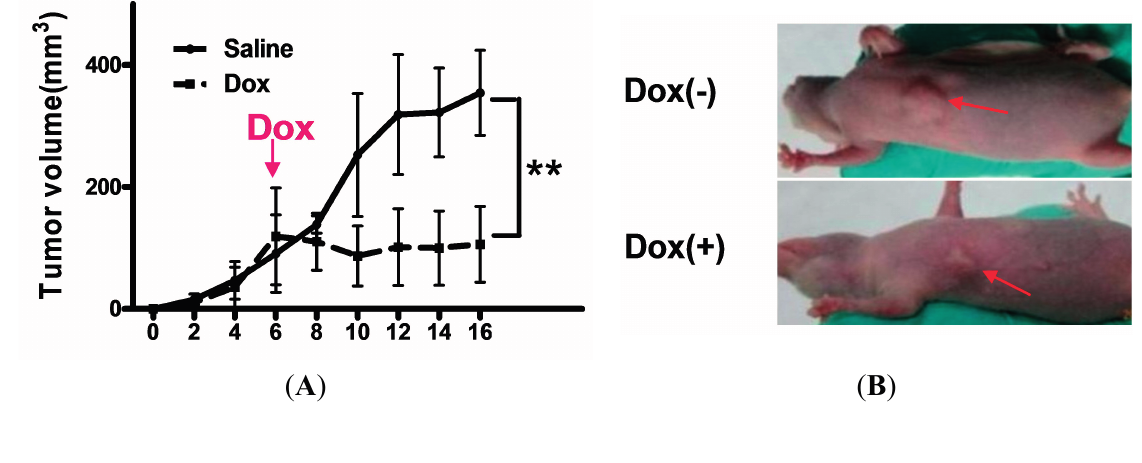
Figure 5. Shutdown of Bmi1 represses the growth of the fast growing tumor in nude mice. ( A ) The growth of tumors in mice with or without doxycycline for 10 days. For the xenograft tumor model, 6 × 10 6 Hep3B cells transfected with pLK-Tet-on-Bmi1 lentivirus were injected per nude mouse. The tumor volume was measured every other day. The treatment group was supplied with 1.5 mg/mL of doxycycline in the drinking water from the sixth day, when the tumors grew to ~100 mm 3 , whereas the control group was supplied still with regular autoclaved water. The pink arrow indicates that the treatment group begun to be supplied with doxycycline (DOX) in the drinking water; ( B ) The doxycycline-treated mice had smaller-sized tumors compared with control group mice. The pictures were taken on the sixth day after doxycycline treatment. The red arrows in each image are used to indicate the tumors; ( C ) The survival curve of tumor-bearing mice. The survival of mice was recorded since the mice were treated with doxycycline. Moribund mice or mice with a tumor ˃ 1000 mm 3 were recorded as dead; and ( D ) Western blotting of Bmi1, apoptosis and cell cycle-associated proteins in the tumor tissues. After the mice were sacrificed, the tumors were collected for western blotting. Data are expressed as the mean ± SD. * p <